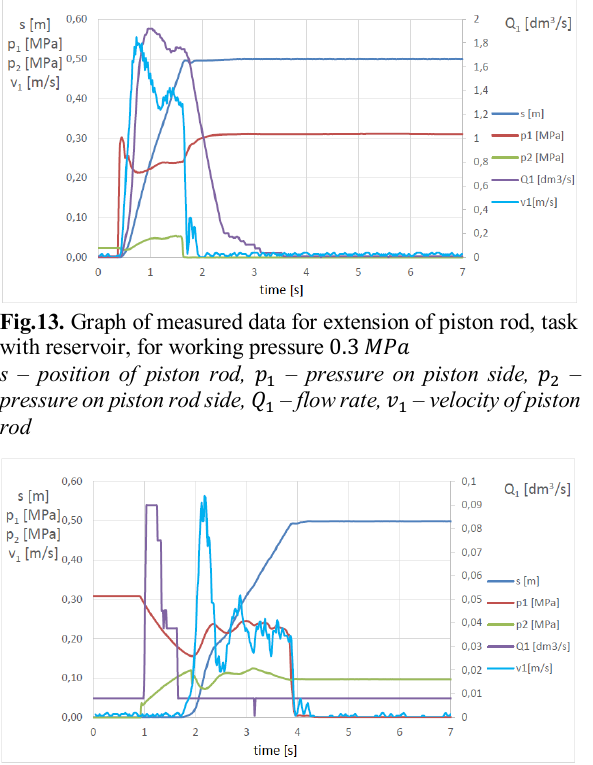
Fig.14. Graph of measured data for extension of piston rod, task with reservoir, for working pressure 0.3 𝑀𝑃𝑎